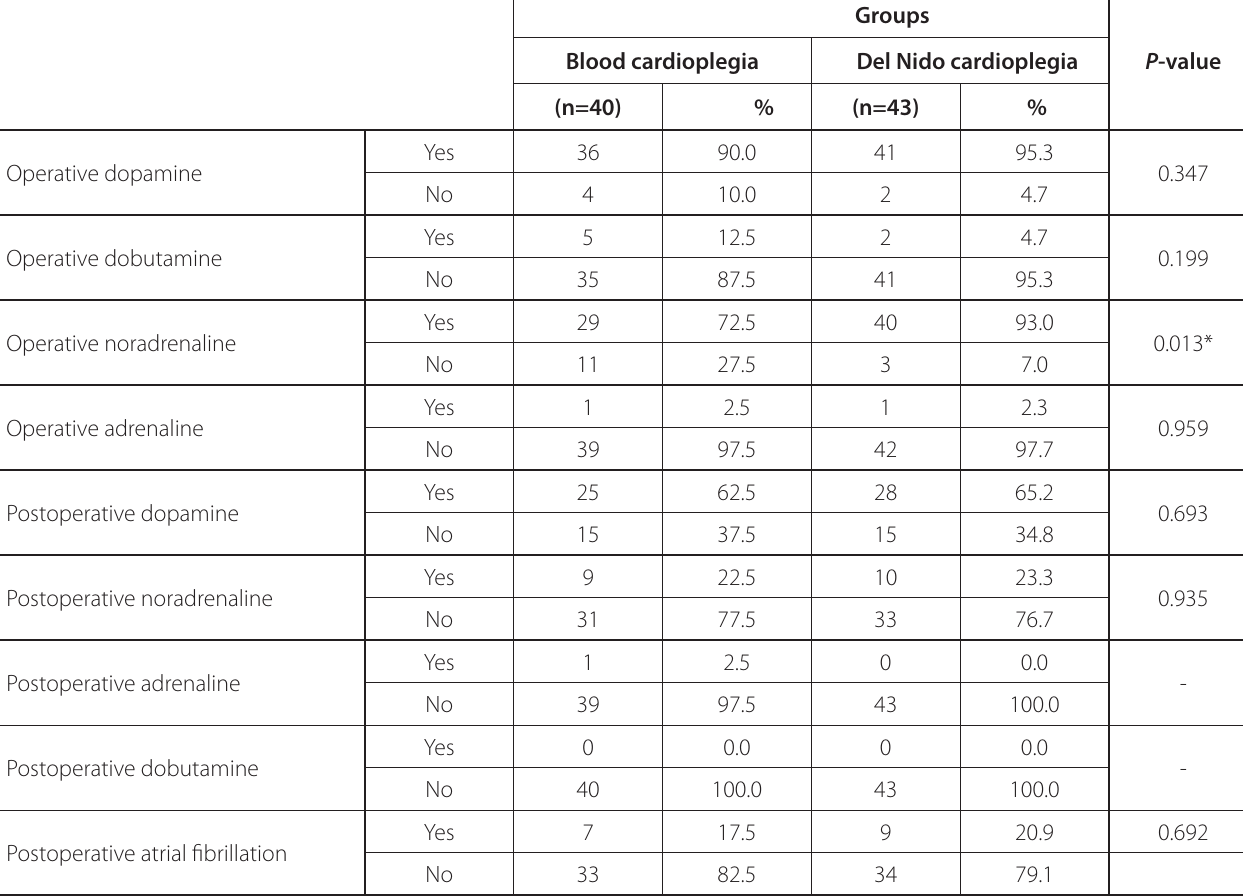
Table 6 . Use of inotropic agent and development of postoperative atrial fibrillation by groups.